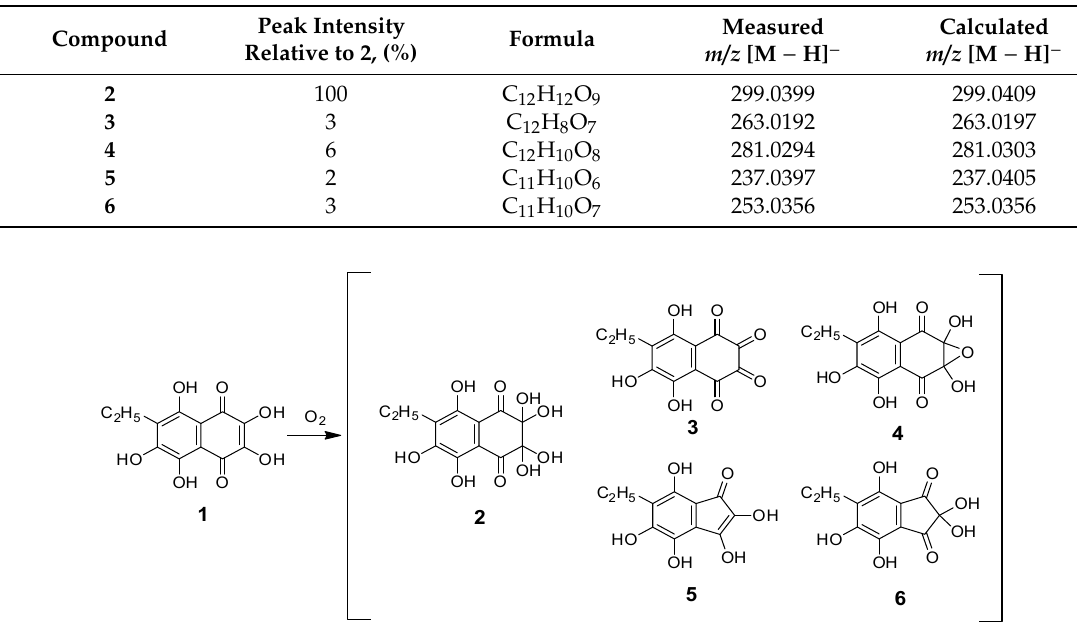
Figure 3. Primary oxidation products of Ech A ( 1 ); structures 3 – 6 were proposed on the basis of HR-ESI-MS